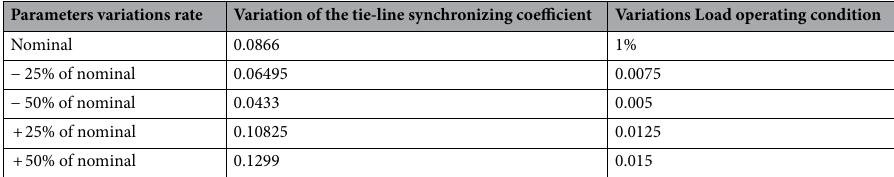
Table 7. Variations in the four-area interconnected power system’s specified